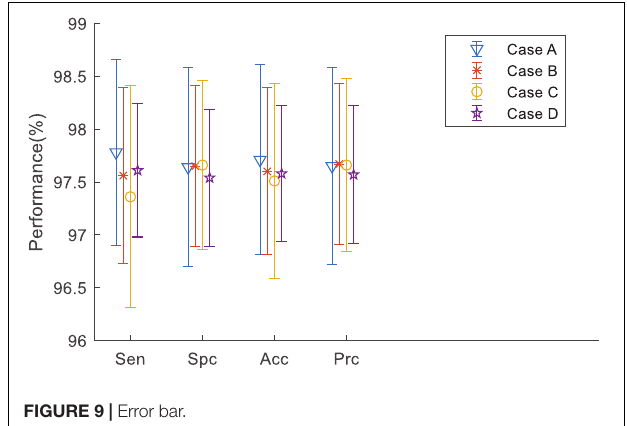
FIGURE 9 | Error bar.